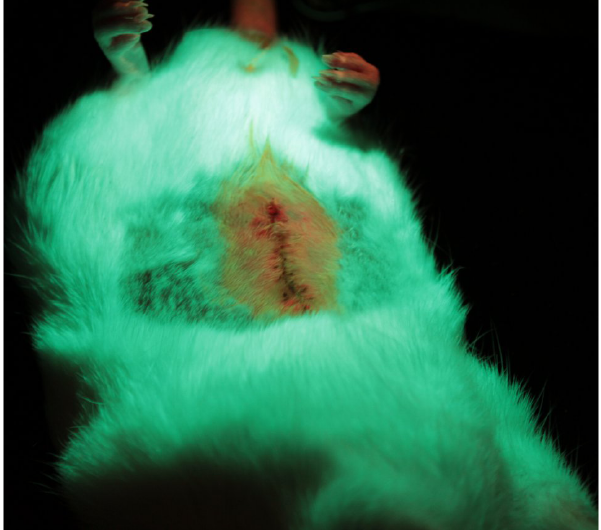
Fig. 2. The lesion on the rat after treatment by Metvix illu- minated by blue light and observed through a yellow ¯lter. The weak red luminescence around the lesion correspond to the PpIX in the healthy tissue while the bright red spots in the scar correspond to much higher concentration of the PS in the scar. The inhomogeneous °uorescence intensity in the scar re°ects uneven distribution of PS in the